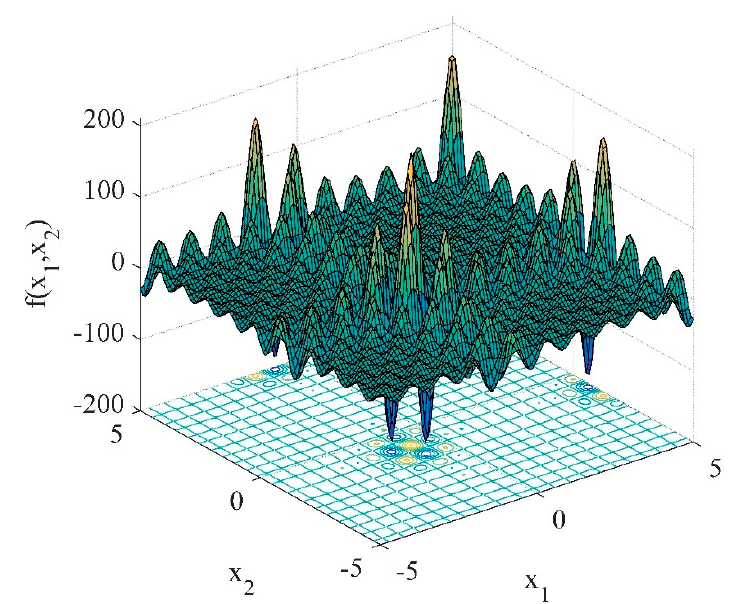
Figure 11. Three-dimensional view of the standard test function.